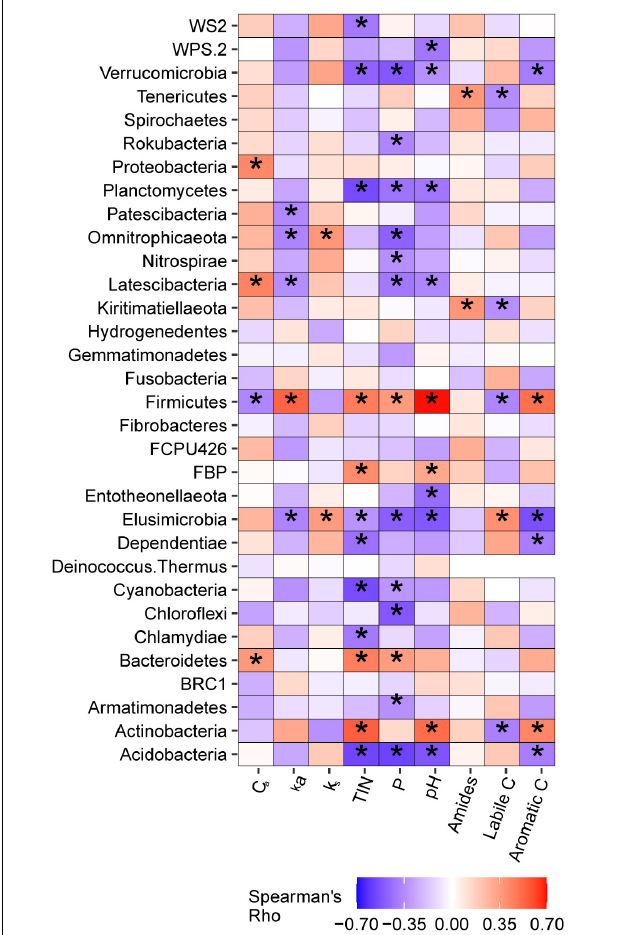
FIGURE 7 | Correlations betweenbacterial phyla and active carbon pool size (C a ) and kinetic rate (k a ), non-active carbon pool kinetic rate (k s ), total inorganic nitrogen (TIN), phosphorus (P), pH, and amide, labile C, and aromatic C regions of MIR spectra of light particulate soil organic matter. *Indicate correlations that were significant at α =